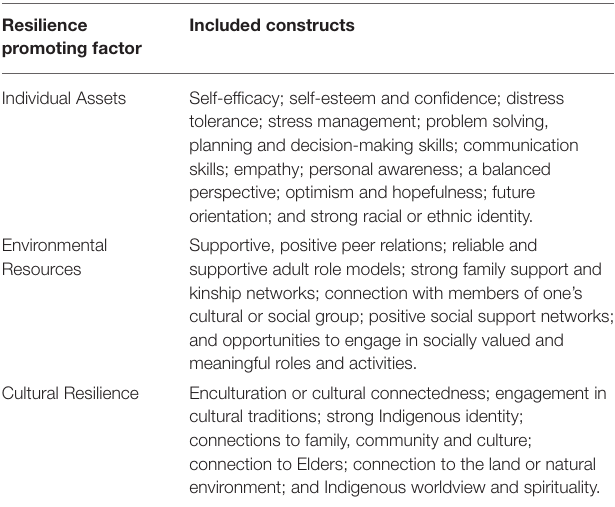
TABLE 1 | Constructs of